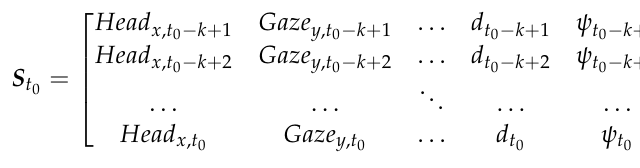
Figure 3. Smart Eye Pro eye-tracking system and DS image. The eye-tracking device relies on infrared cameras (indicated in the photo) to track the movement of the head and eyes. Table 1. Details of monitoring data.